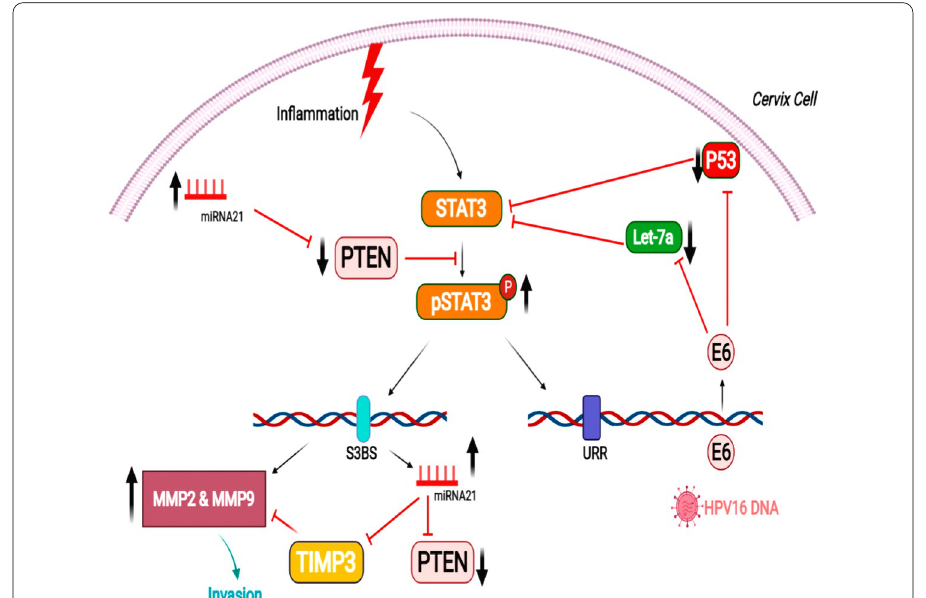
Fig. 3 Interaction of HPVE6–miRNA–STAT3 during cervical carcinogenesis. URR, upstream regulatory region; , upregulation; , downregulation; S3BS, STAT3 binding ↑ ↓